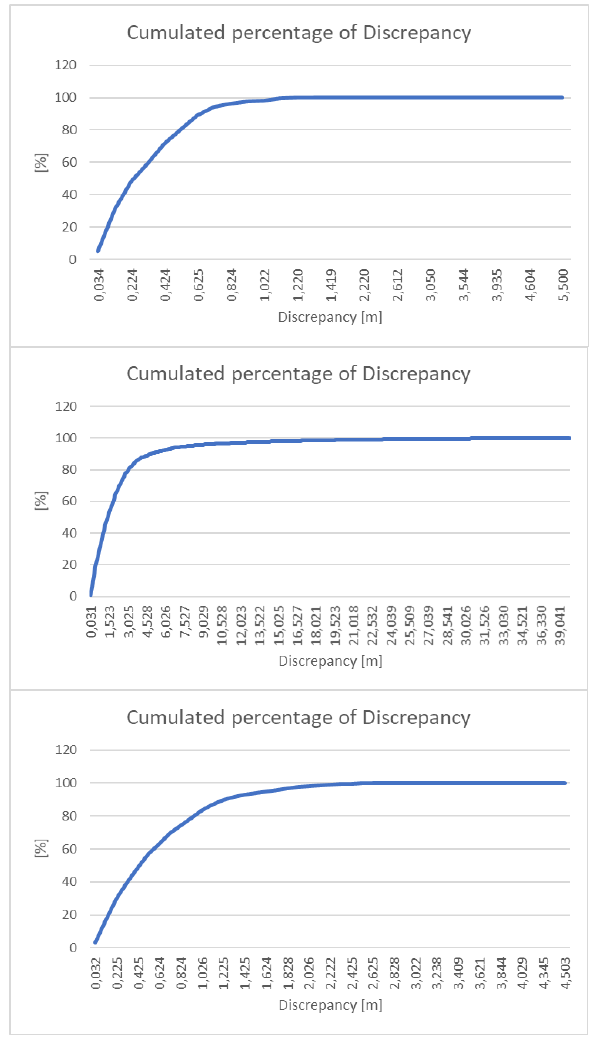
Figure 7. Cumulated percentage of discrepancy for the “Vaihingen” (on the top), “Toronto” (in the middle) and “Tobermory” (at the bottom) Data sets, respectively. Discrepancies are computed with respect to “reference” centrelines from